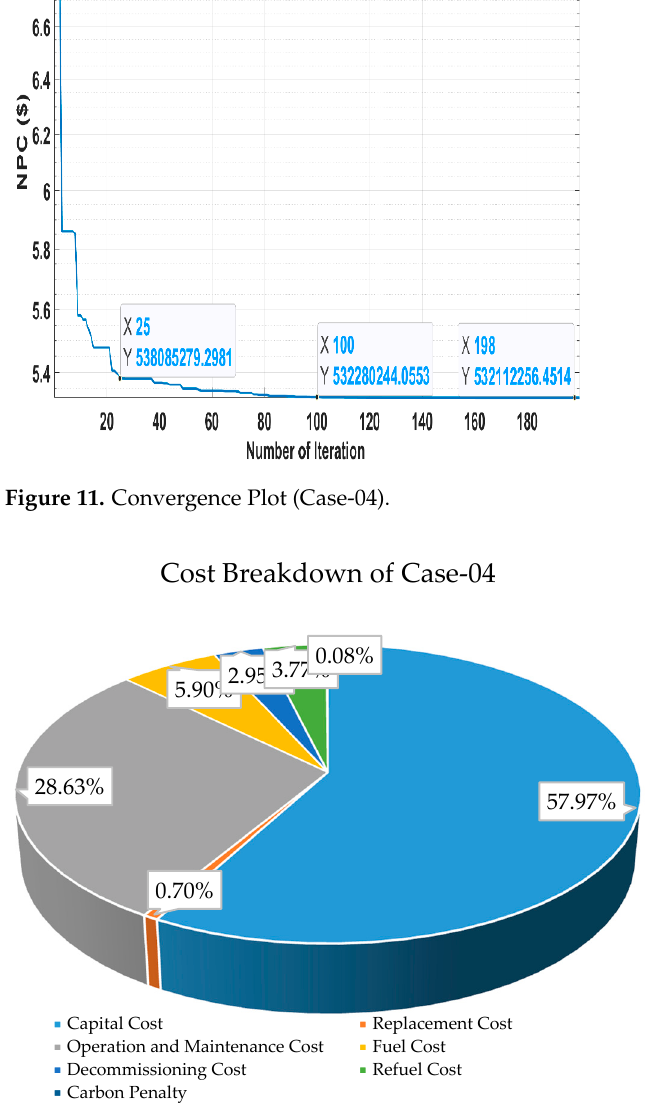
Figure 12. Cost Distribution (Case-04).